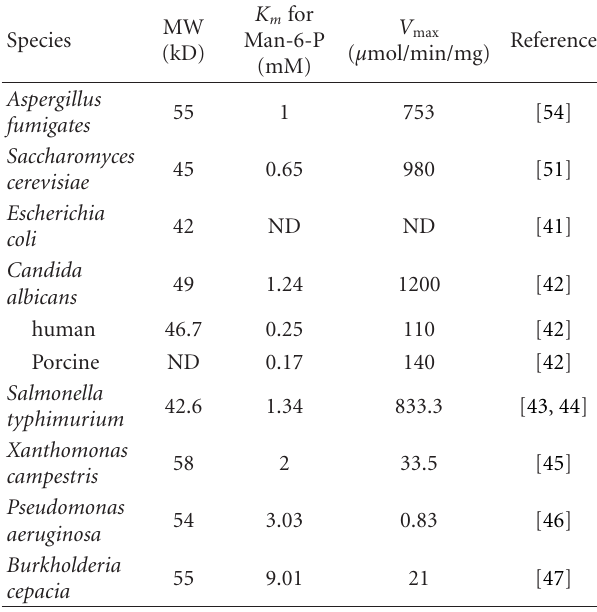
Table 1: Properties of PMIs from di ff erent